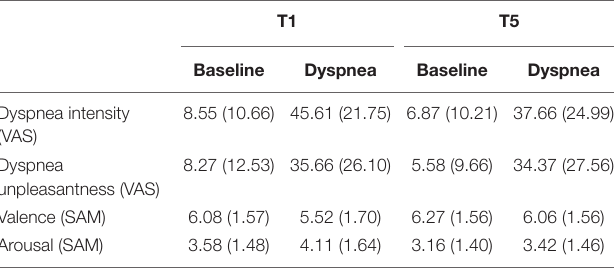
TABLE 2 | Means ( SD ) for ratings of dyspnea and affective state for each condition for T1 and T5. T1 T5 Baseline Dyspnea Baseline Dyspnea